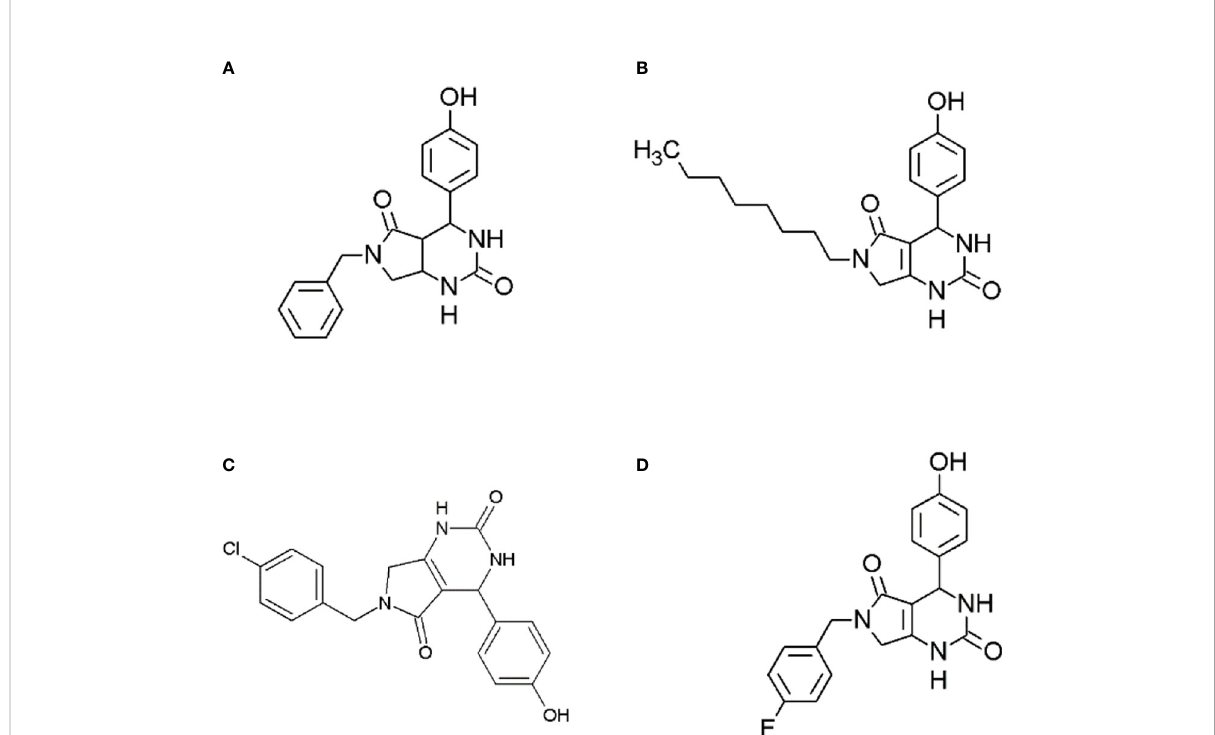
FIGURE 1 Structures of synthesized dihydropyrimidinone derivatives, (A) 6-benzyl-4-(4-hydroxyphenyl)-3,4,6,7-tetrahydro-1H-pyrrolo[3,4-d]pyrimidine-